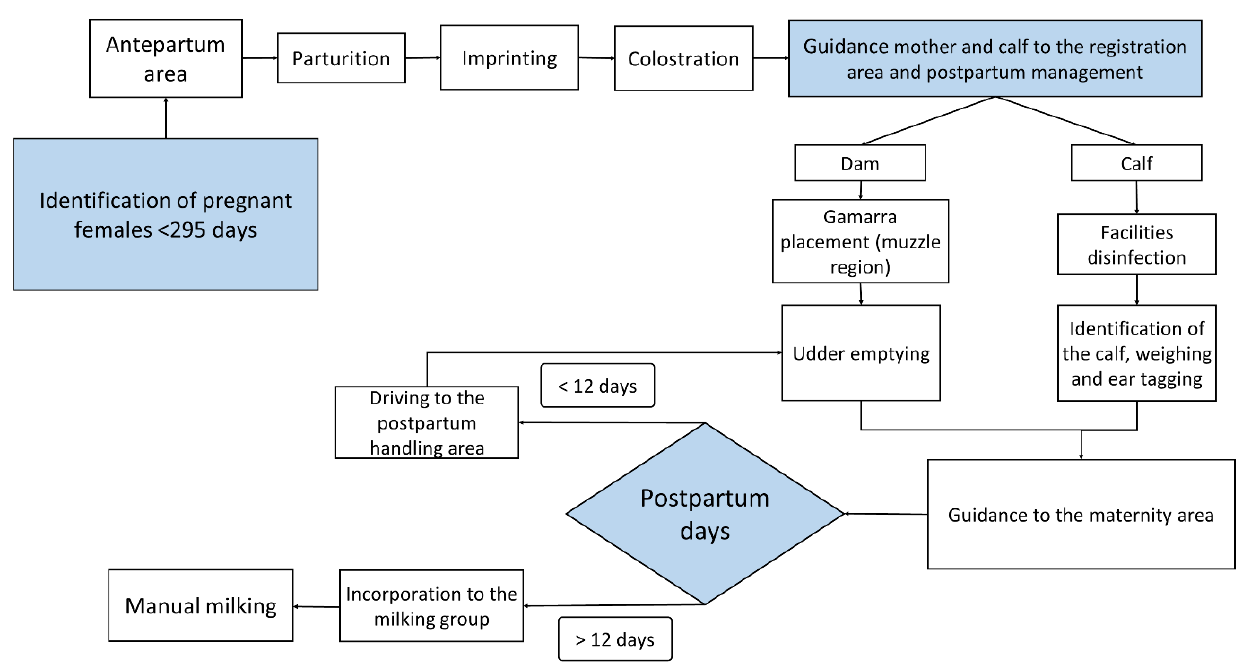
Figure 7. Criteria for handling in the calf and dam.